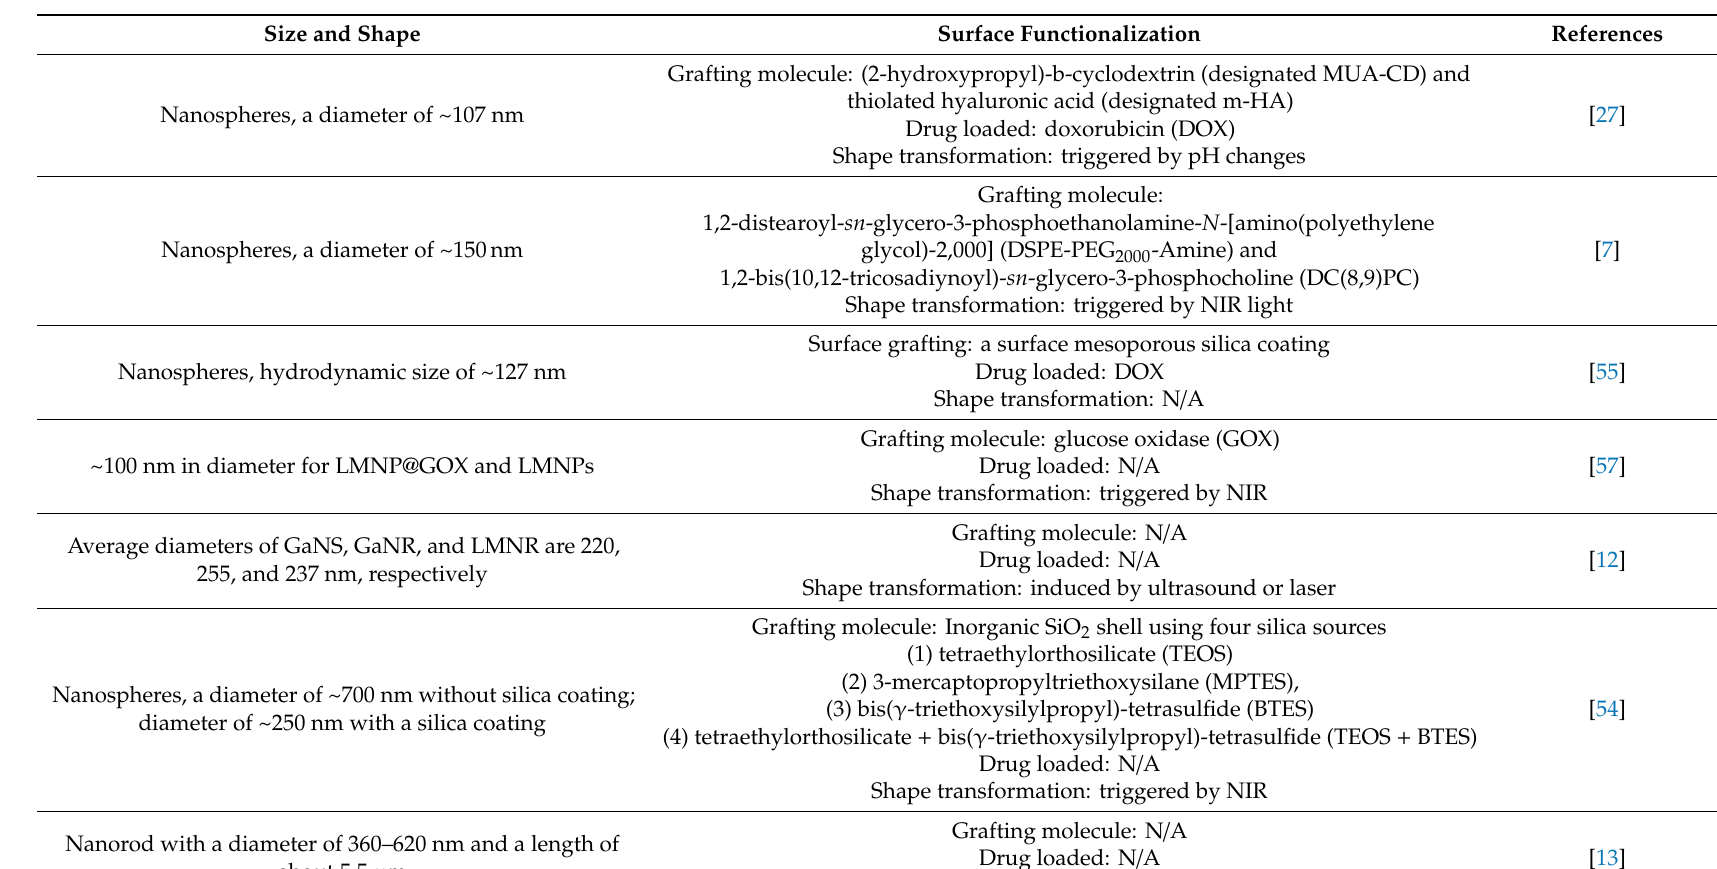
Table 2. Strategies developed for producing biofunctional LMNPs for treating cancer